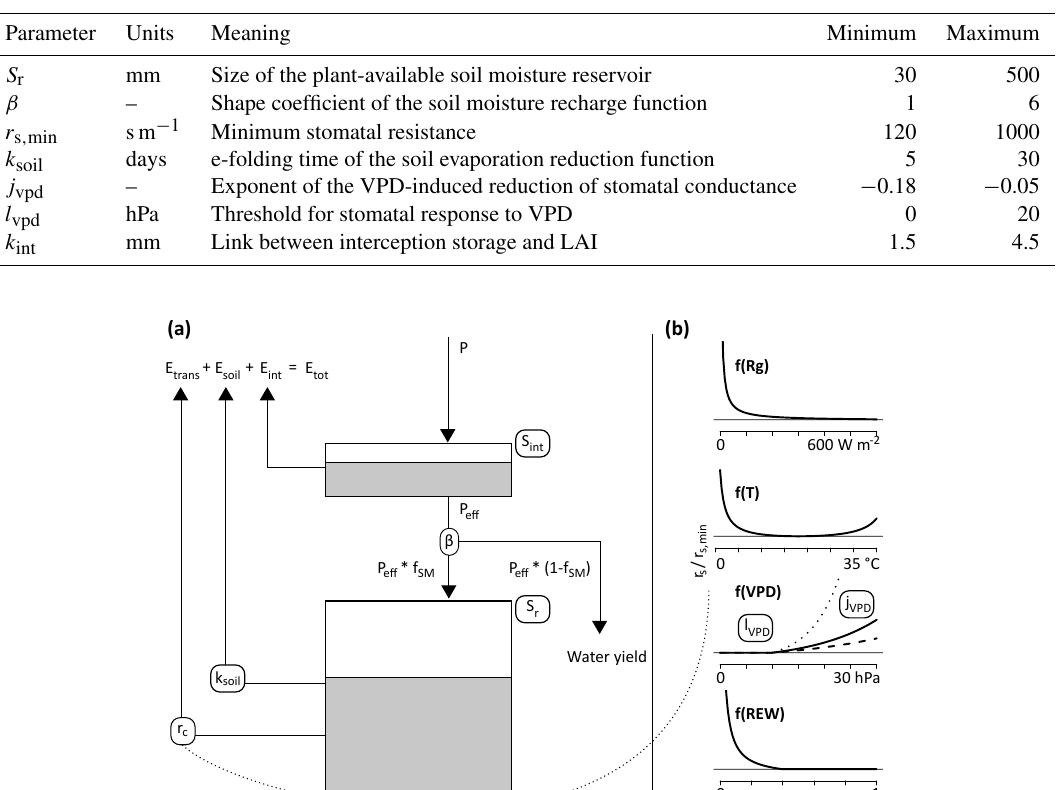
Table B1. Ranges of the calibration parameters used in this study.